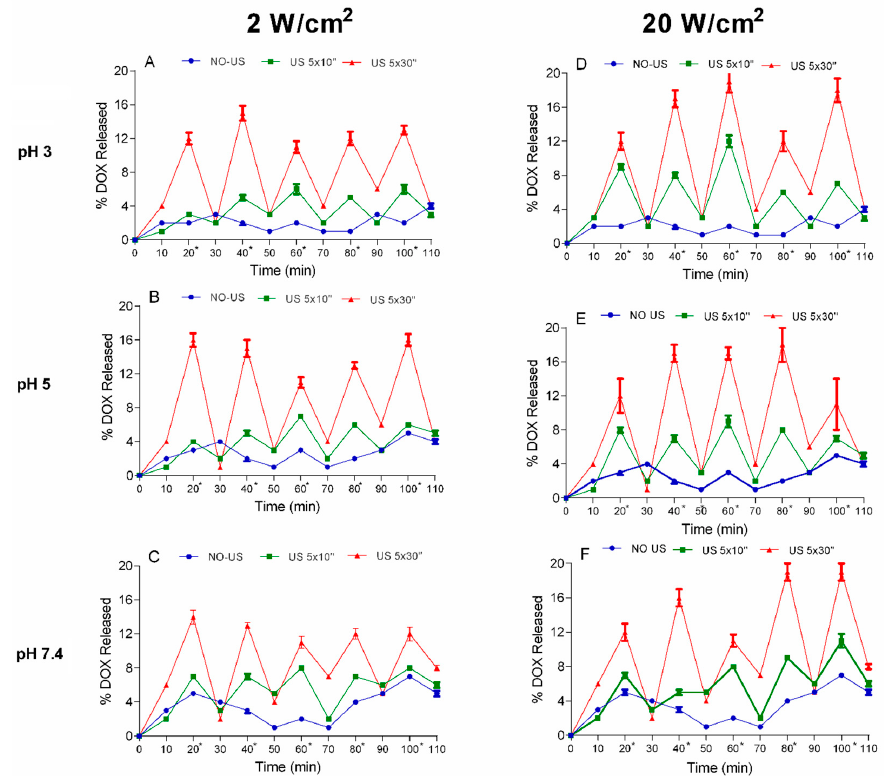
Figure 5. Evaluation of the e ff ect of the US in terms of power and application time on the DOX release in di ff erent media. Values are reported as averages, and error bars represent the SD (n = 3) ( A ) release at pH 3 and US power 2 W / cm 2 ; ( B ) release at pH 5 and US power 2 W / cm 2 ; ( C ) release at pH 7.4 and US power 2 W / cm 2 ; ( D ) release at pH 3 and US power 20 W / cm 2 ; ( E ) release at pH 5 and US power